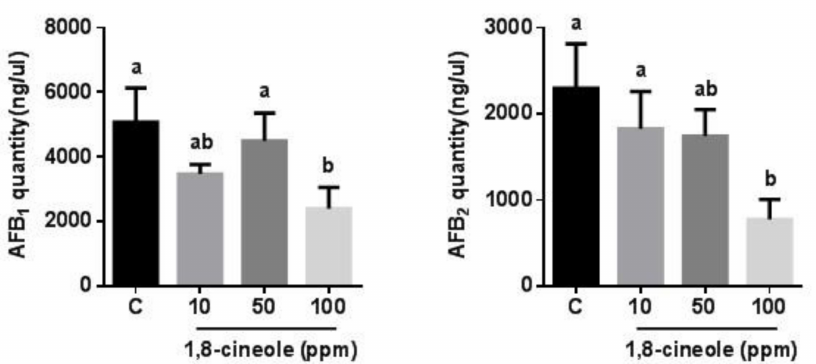
Figure 2. Effects of 1,8-cineole on aflatoxin production by Aspergillus flavus . AFB 1 , aflatoxin B 1 ; AFB 2 , aflatoxin B 2 . Different letters above the same column indicate significant differences among the treatments. Data are presented as the mean ± SD.